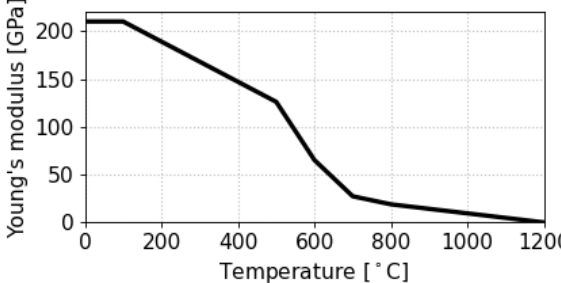
Figure 18. Temperature-dependent young’s modulus of steel, given by EC3.